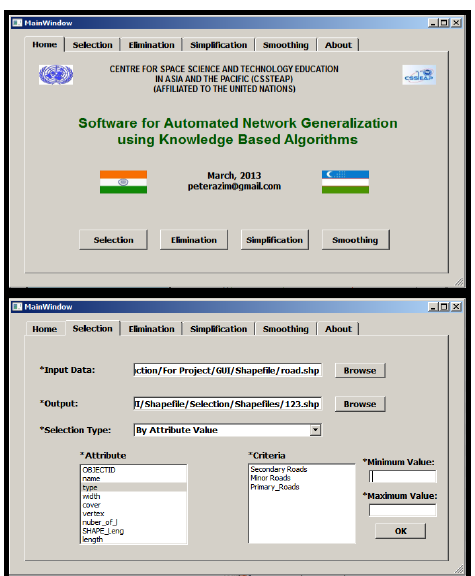
Figure 6: Interface of the generalization tool The algorithm was experimented with several tolerances and best resembled map with the target map scale 1:50 000 was taken as a road network simplification tolerance for the current map scale.